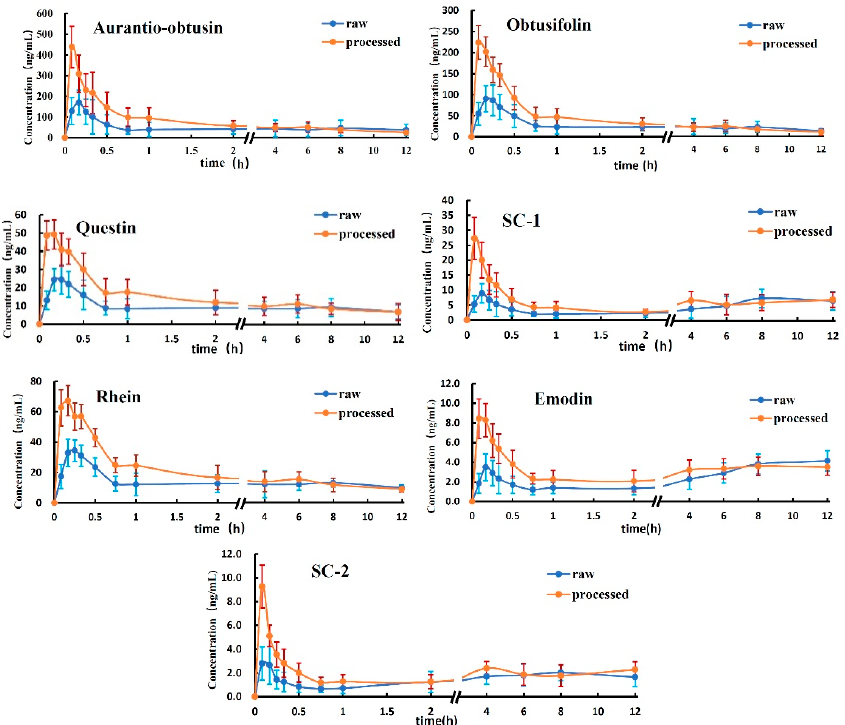
Figure 3. Plasma concentration-time of the analytes in rats given single oral administration.